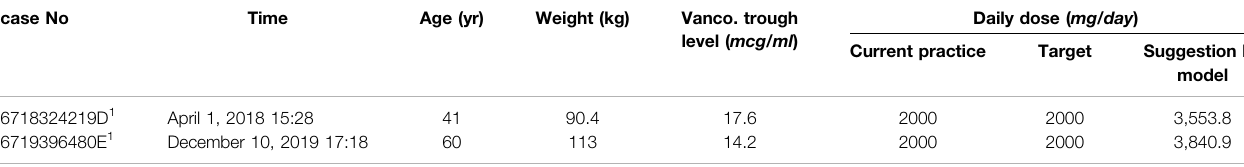
TABLE 5 | Examples of the initial dose model showing different target daily doses and suggested daily doses.